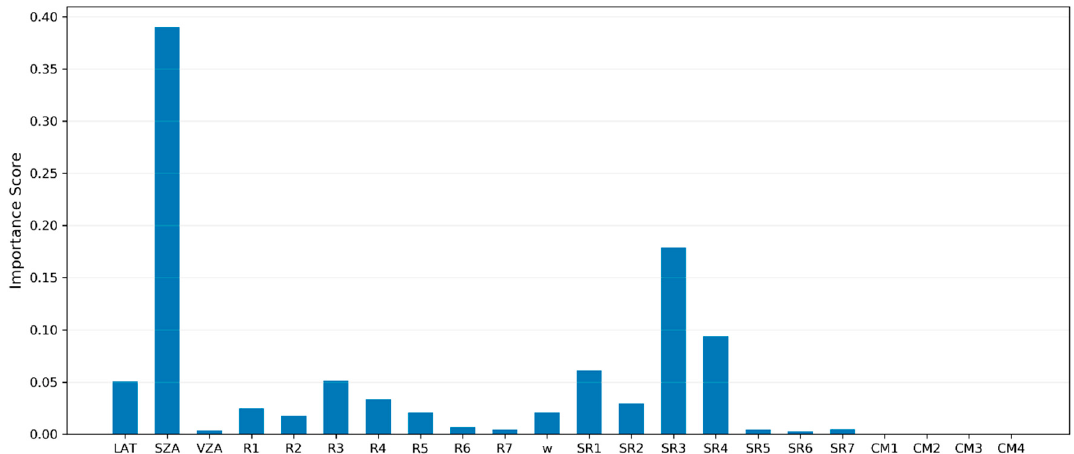
Figure 11. The importance score of selected independent variables in NSSR retrieval.